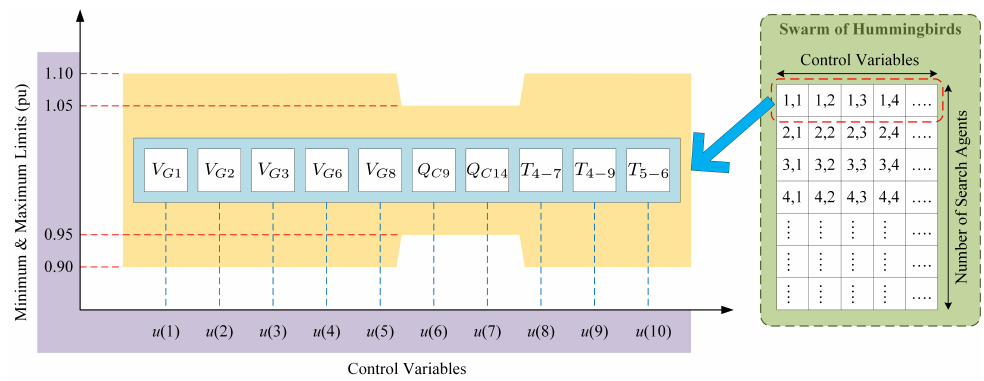
Figure 1. Mapping procedure for control variable of ORPD